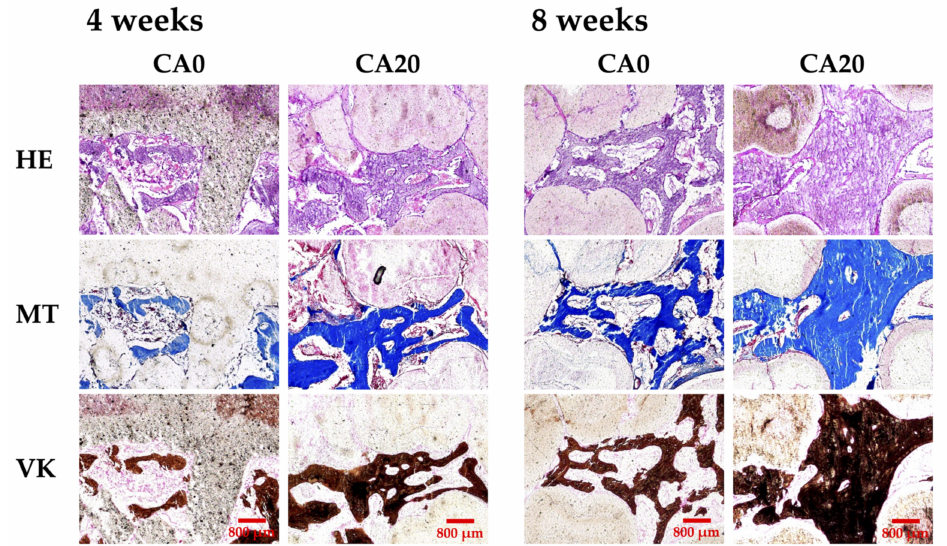
Figure 10. Hematoxylin-eosin (HE), Masson’s trichrome (MT) and von Kossa (VK) staining evaluating new bone regeneration quality of CA0 and CA20 scaffolds in a critical-sized bone defect in vivo at 4 and 8 weeks of implantation. The scale bar is 800 µ